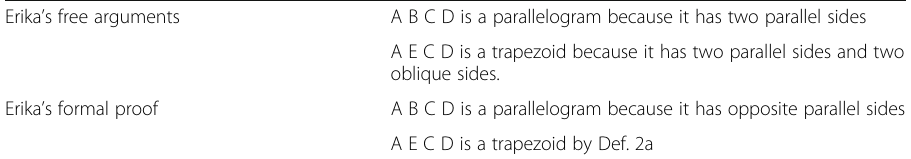
Table 1 Example of student ’ s answers by means ISQ Erika ’ s free